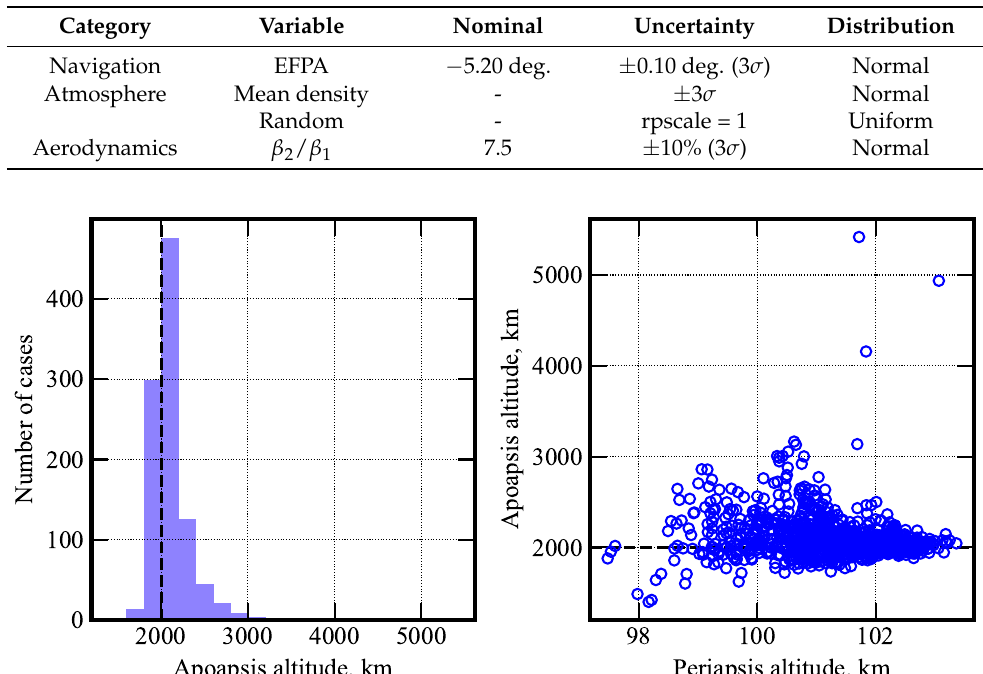
Table 10. Venus aerocapture Monte Carlo uncertainties.